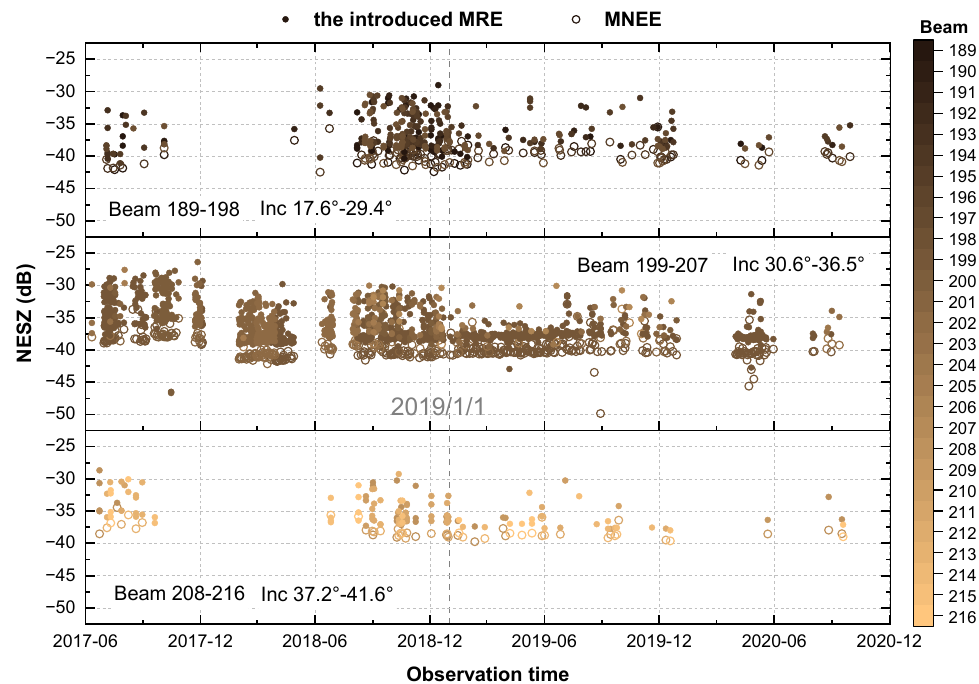
Figure 3. The NESZ evaluation results of the GaoFen-3’s QPSI mode from June 2017 to September 2020. The three stacked plots represent the noise estimation in different imaging beams, distinguished in different colors. Inc means the nominal incident angle. The solid scatters are the introduced MRE measurements, and the circle scatters denote the lower estimation by MNEE [3].